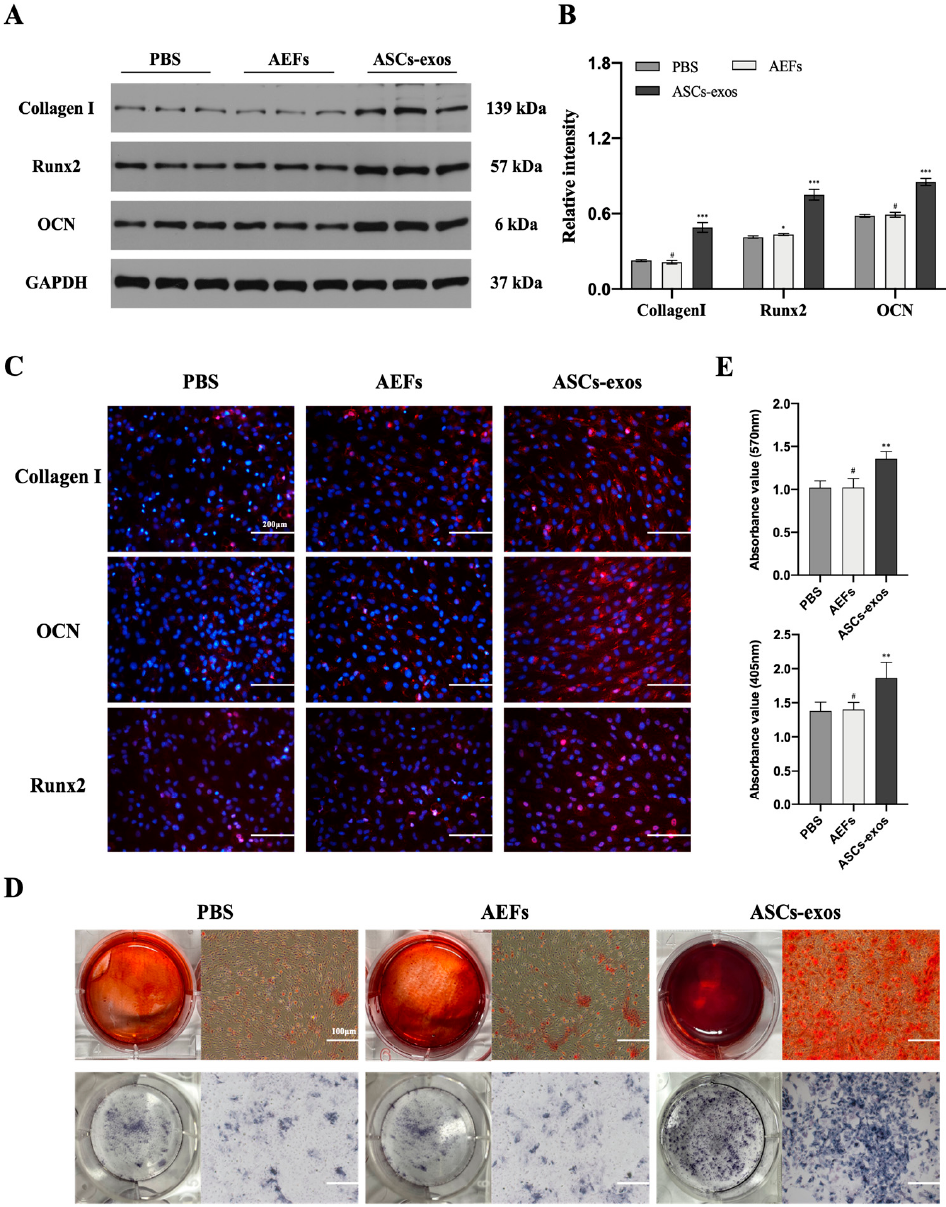
Figure 2. ASCs-exos facilitate BMSC osteogenesis differentiation in vitro. ( A , B ) The protein levels of Runx2, collagen I and OCN in BMSCs treated with PBS, AEFS or ASCs-exos were measured by Western blotting. ( C ) Immunofluorescence staining for collagen I, OCN and Runx2 in different groups. ( D ) The images of ARS and ALPS of BMSCs after 14 days of incubation with PBS, AEFS or ASCs-exos. ( E ) The statistical analysis of ARS and ALPS of BMSCs treated with PBS, AEFS or ASCs-exos for 14 days. Scale bars, 100 μ m. Data are presented as the mean ± SD, and all experiments were repeated three times. * p < 0.05, ** p < 0.01, *** p < 0.001, # p > 0.05.